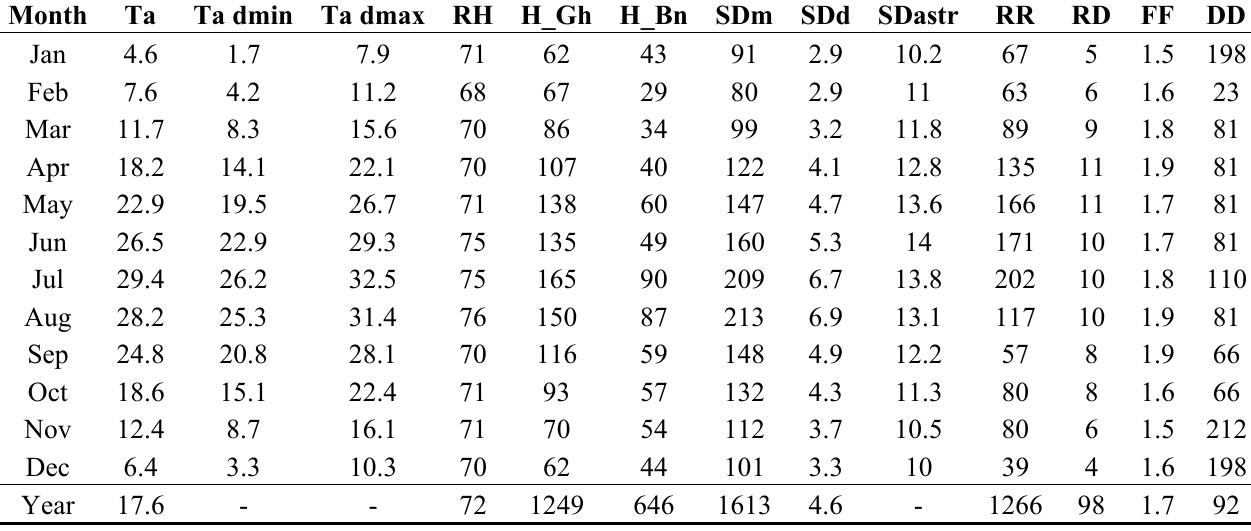
Table 4. Table of Wuhan (30°N) climate data summary (MeteonormV6.1 data period: 1996–2005).